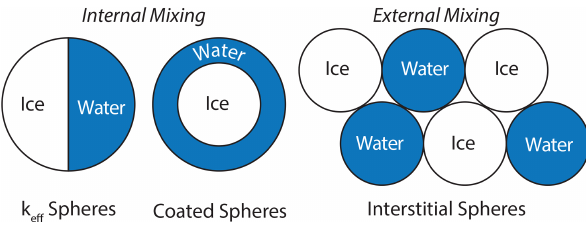
Figure 2. A schematic of three ice and water optical mixing models used to simulate the reflectance of wet